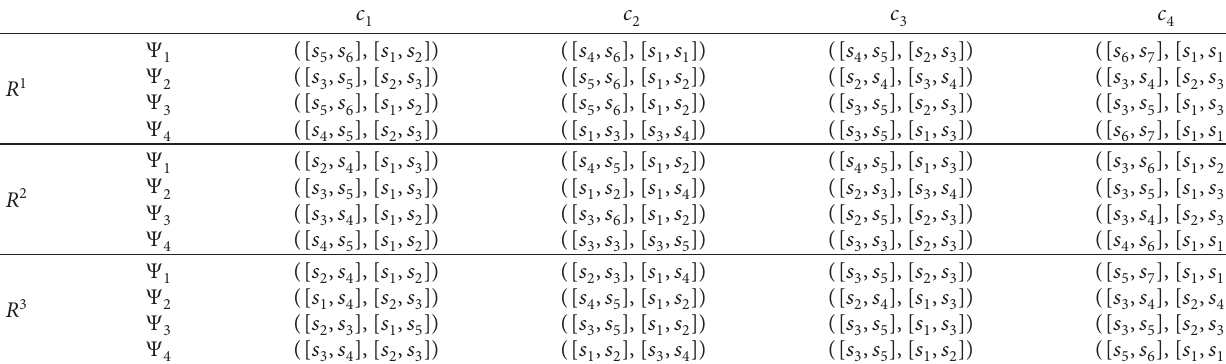
Table 2: Decision matrix R k ( k � 1 , 2 , 3 ) .